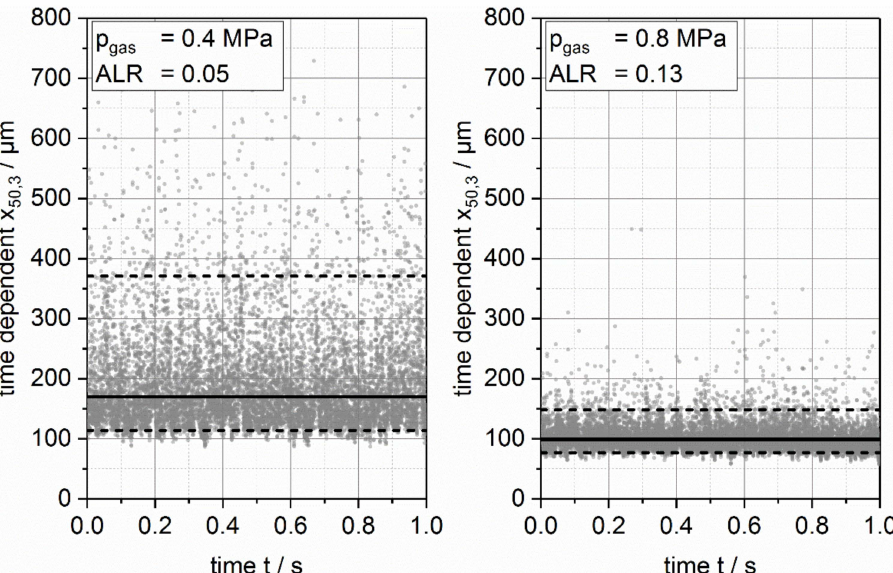
Figure 4. Time dependent values of the 50th percentile of the volumetric sum distribution x 50,3 (grey dots) at µ = 0.39 Pa · s and Q L = 40 L · h − 1 are shown for measurements at p gas = 0.4 MPa ( left ) and p gas = 0.8 MPa ( right ). Additionally, the 5th percentile x 5,0 (lower dashed line), 50th percentile x 50,0 (solid line) and 95th percentile x 95,0 (upper dashed line) of x 50,3 are